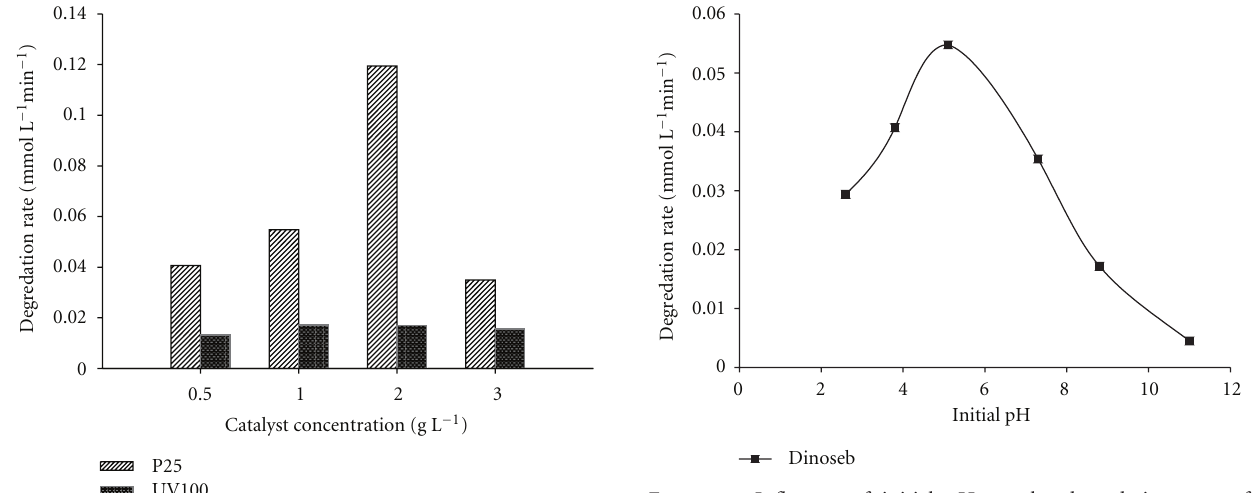
between TiO 2 loading (Degussa P25 and Hombikat UV100) and photodegradation rate of dinoseb is shown in Figure 4.